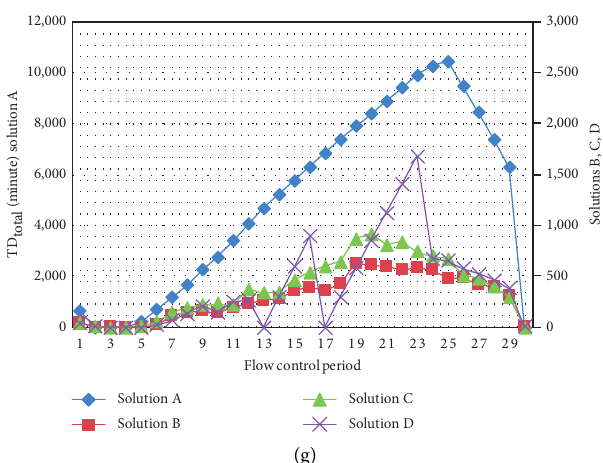
Figure 15: Seven indicator comparison with different solutions on Communication University Station in each period. (a) Controlled passengers at entrance. (b) Left-behind passengers at the platform. (c) Waiting passengers at entrance. (d) Waiting passengers at platform. (e) Flow control delay of passengers at the entrance. (f) Left-behind delay of passengers at the platform. (g) Total delay of passenger travel time.